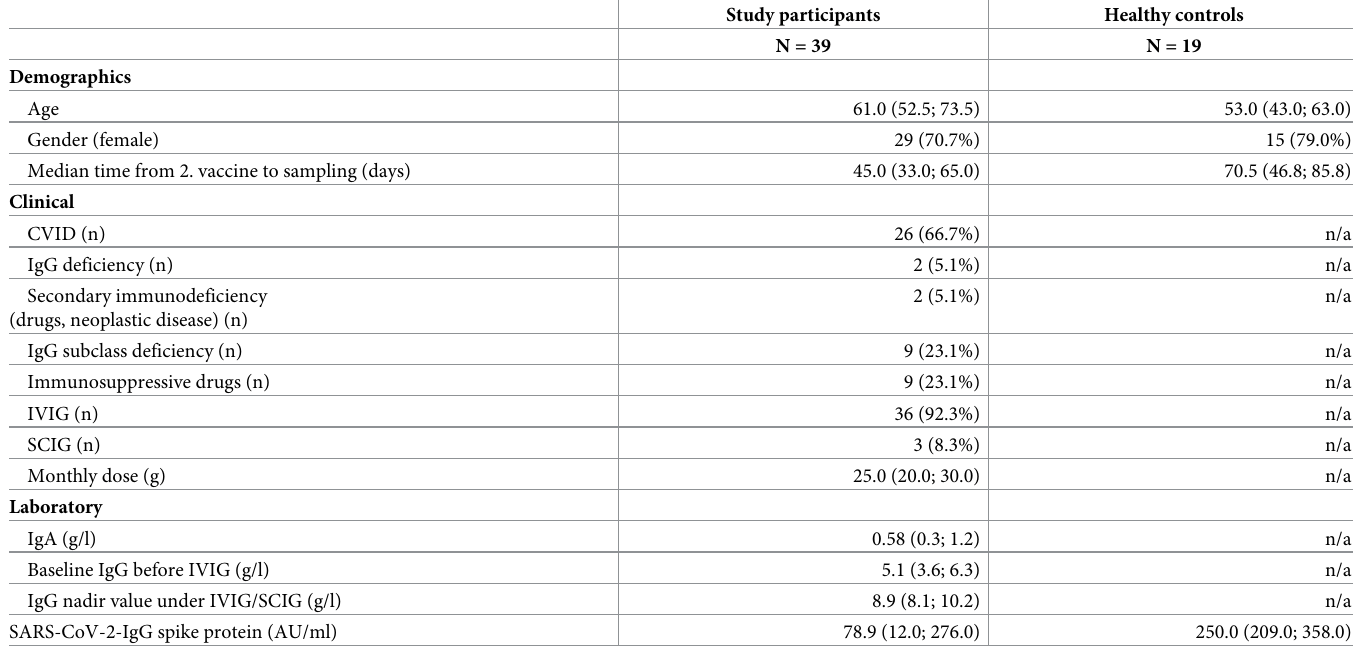
Table 1. Patient